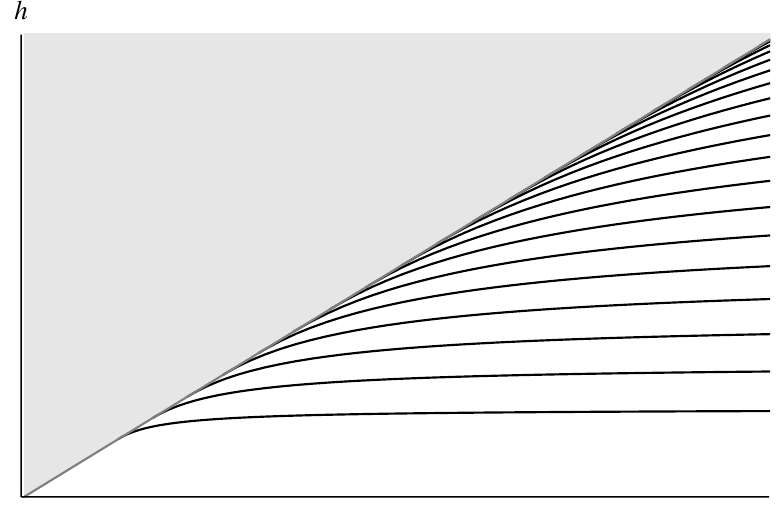
Figure 1 . The twist spectrum of Virasoro double-twist operators arising from inversion of the holomorphic vacuum block, i.e. the spectrum of VMFT. The twists of the external operators are (cid:12)xed while c varies. For a given central charge c , there is a discrete number of operators, shown as the solid lines, below the continuum at h > c (cid:0) 1 , shaded in grey. The exact formula for the twists is 24 given in (1.8) . Each line, when combined with an anti-holomorphic component, forms a quantum Regge trajectory that is exactly linear in spin. At large c , one recovers the integer-spaced operators of